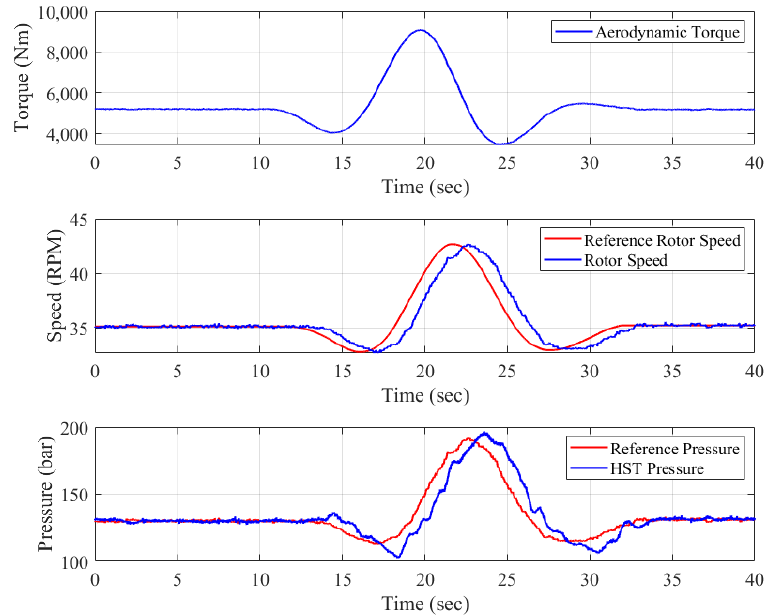
Figure 8. Performance of the HST wind turbine to a gust